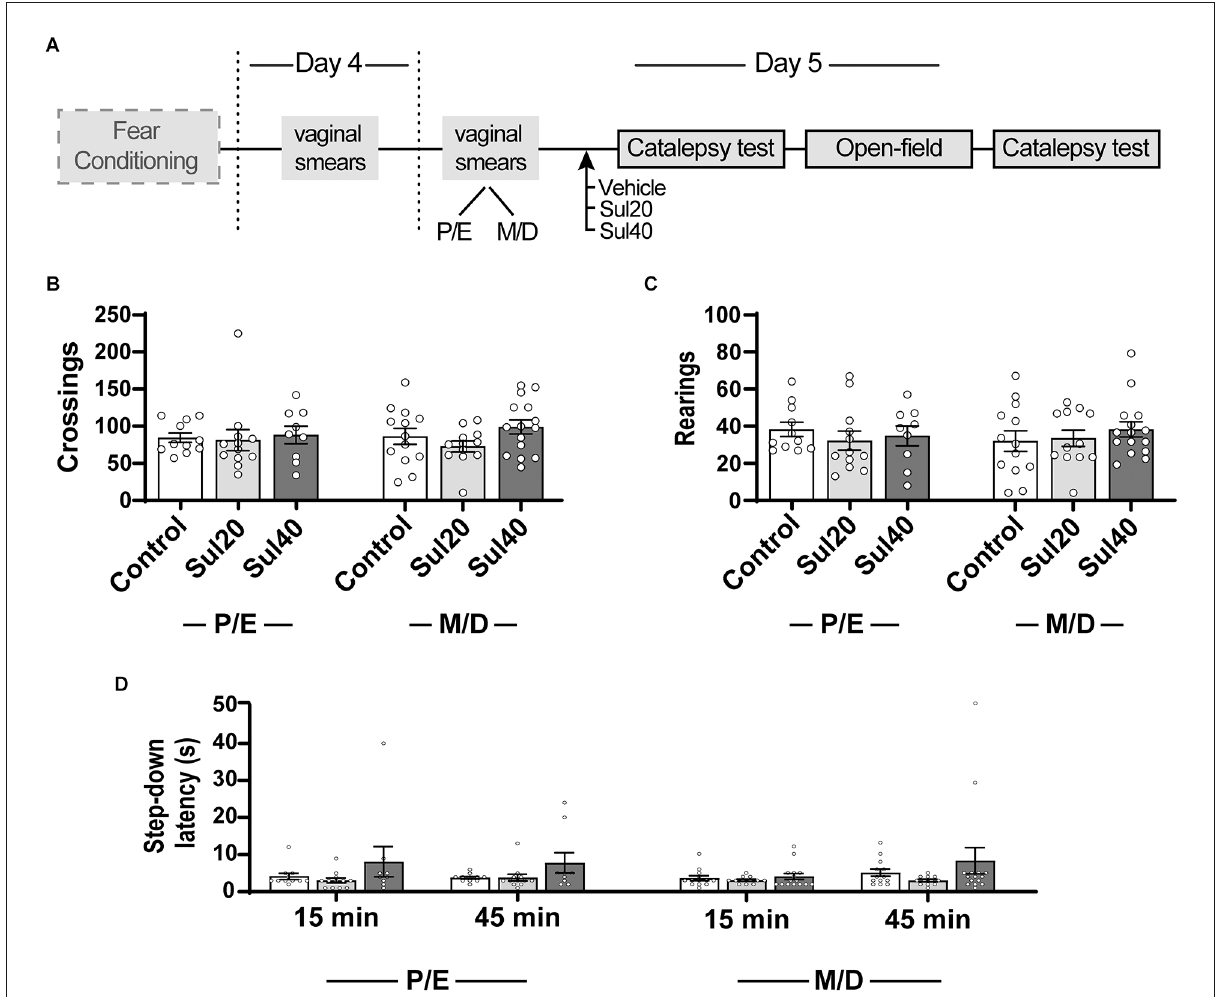
FIGURE3 Sulpiride 20 and 40 mg/kg did not affect motor performance in the open-field and catalepsy tests in female rats in proestrus/estrus (P/E) and metestrus/diestrus (M/D). (A) Timeline of the experimental procedure. (B) The total number of crossings in the open-field test. (C) The total number of rearings in the open-field test. (D) Latency to step-down in the catalepsy test 15 and 45 min after treatments. Females P/E: n = 11 for Control, 12 for Sul20, 9 for Sul40; Females M/D: = 13 for Control, 12 for Sul20, 15 for